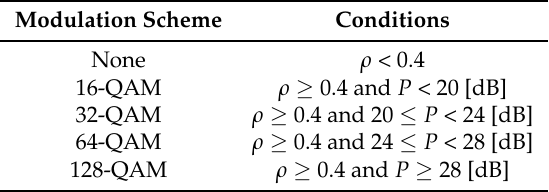
Table 2. Adaptive modulation scheme for eight user terminals (UTs).